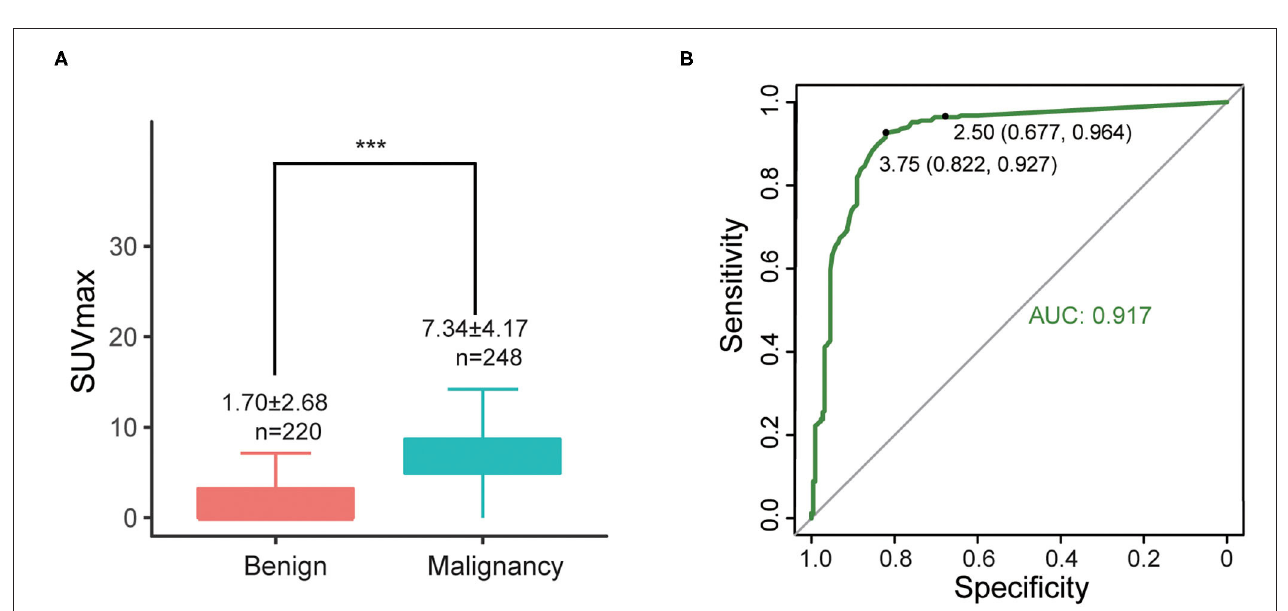
FIGURE 2 | (A) Differences of SUVmax between malignant and benign groups, *** P < 0.001; (B) ROC curve of SUVmax (all cases).